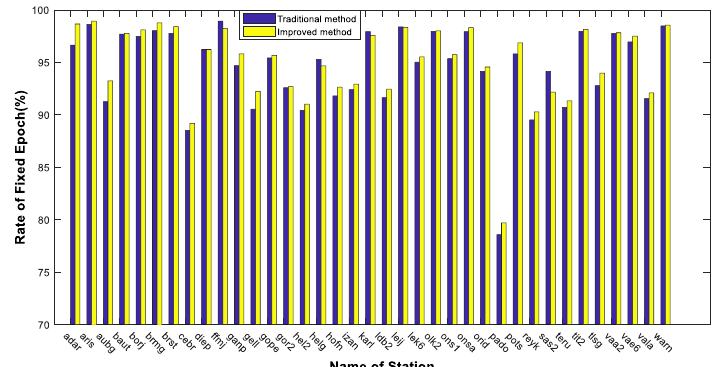
Figure 10. Rate of fixed epochs by using different bias products (2021, day 185).